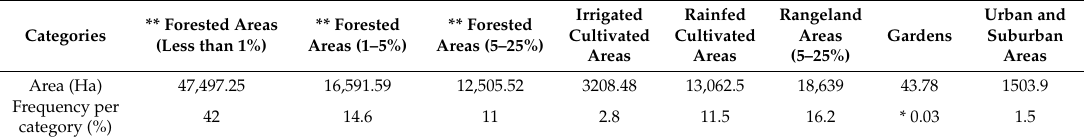
Table 1. Classes names of Landuse for the study